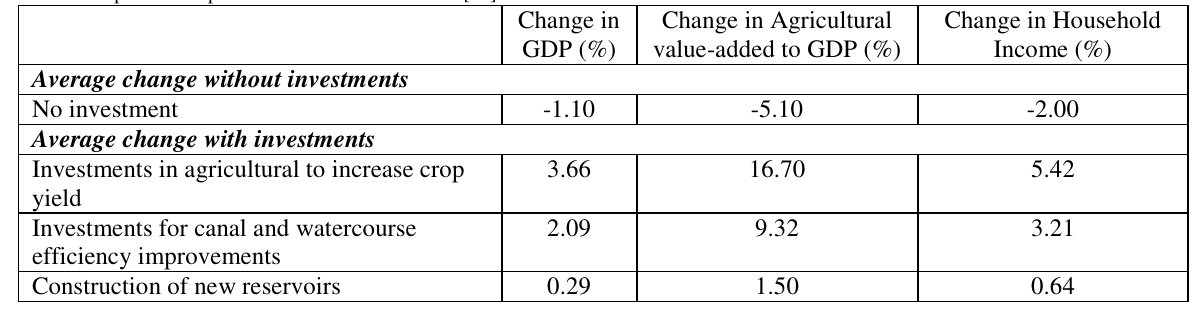
Table 5 : Impact of Adaptation Investments in Pakistan [15]